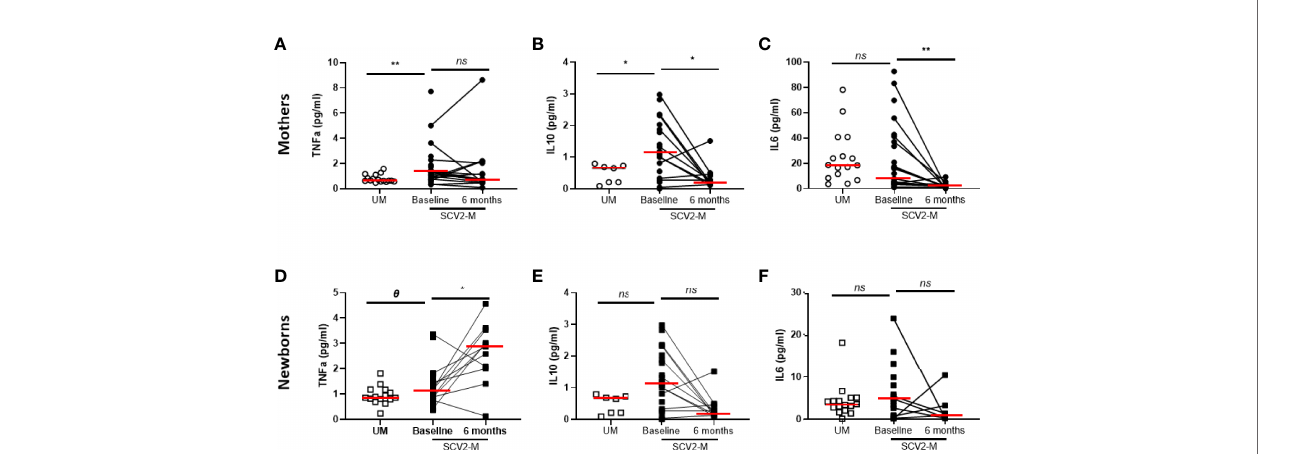
FIGURE 1 | Soluble pro/anti-in fl ammatory cytokine levels in plasma. Differences at baseline and 6 months later. Soluble TNF- a , IL-10 and IL-6 levels from mothers and newborns ’ plasma at baseline and after 6 months (A-F); Mann-Whitney U-test was used to compare groups. Wilcoxon test was conducted to compare paired events. SCV2-M, SARS-CoV2 mothers ’ group; UM, Uninfected mothers ’ group. **p ≤ 0.01 , *p<0.05 , Ɵ 0.05 ≤ p ≤ 0.1 , ns p>0.1